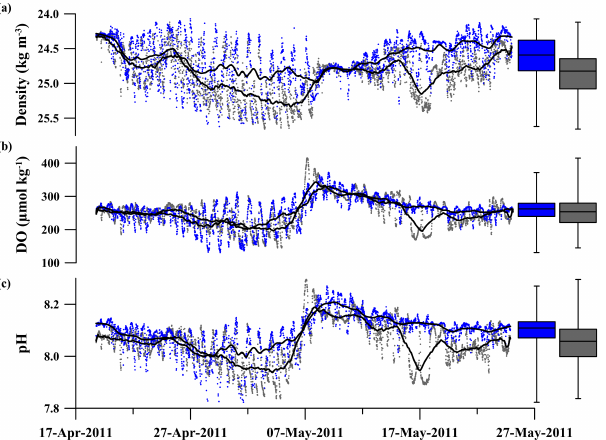
Fig. 8. Cross-shore differences in time series and corresponding box plots of (a) density, (b) dissolved oxygen (DO) and (c) pH. From 28 September 2010–10 November 2010, one SeapHOx was deployed at mooring B, 3.5km from the coast (red), and the other SeapHOx was deployed at mooring A, 1.9km from the coast (grey). From 26 September 2011–18 October 2011, one SeapHOx was deployed at mooring A, 1.9km from the coast (grey), and the other SeapHOx was deployed at mooring C, 1.4km from the coast (orange). Black solid lines are 2-d smoothed data. Density scale is reversed. Box plot depicts the minimum, maximum, median, lower quartile and upper quartile for corresponding time-series data. ND=no